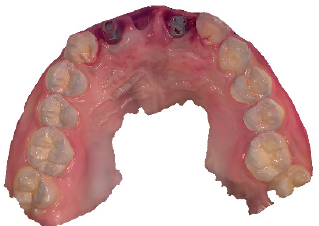
Figure 3. Digital intraoral impressions obtained with an intraoral scanner (Trios 3, 3Shape, Copenhagen, Denmark) and scan bodies (Geo Scanbody, GeoMedi, Uiwang-si, Korea).